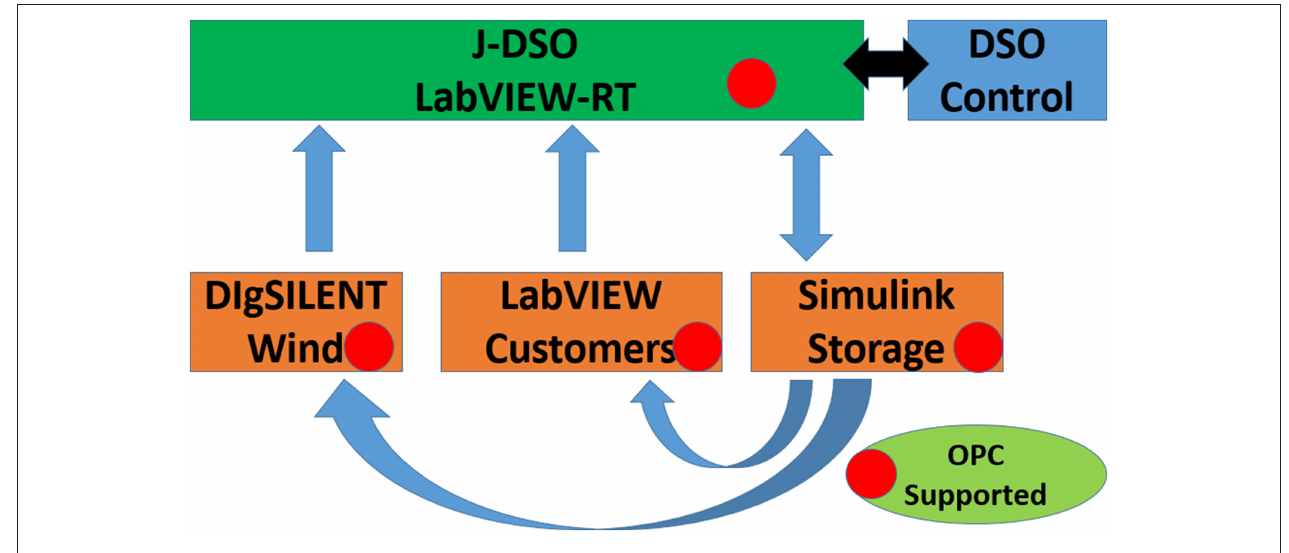
FIGURE 5 | Co-interface